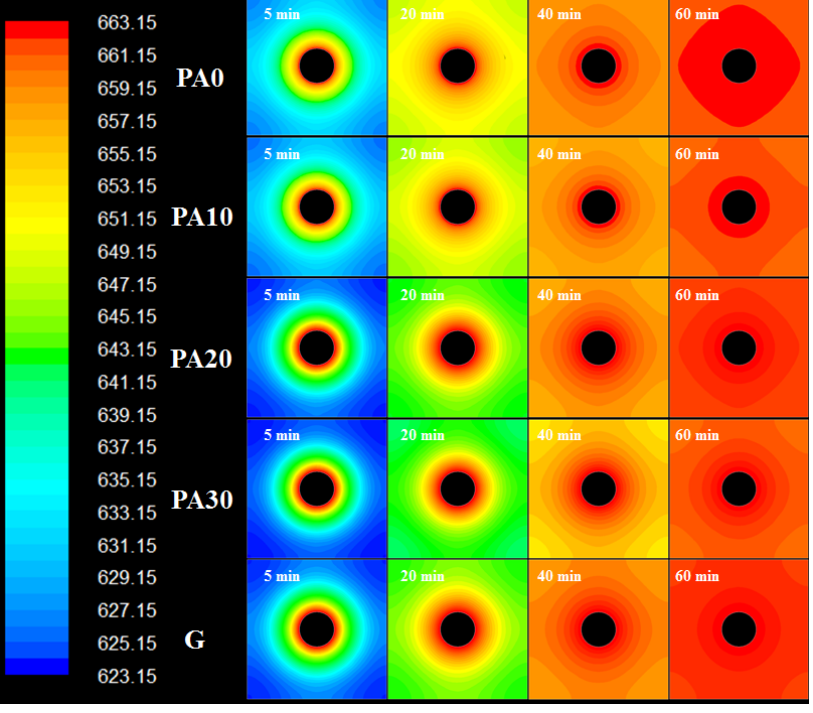
Figure 16. Temperature contour maps at constant V